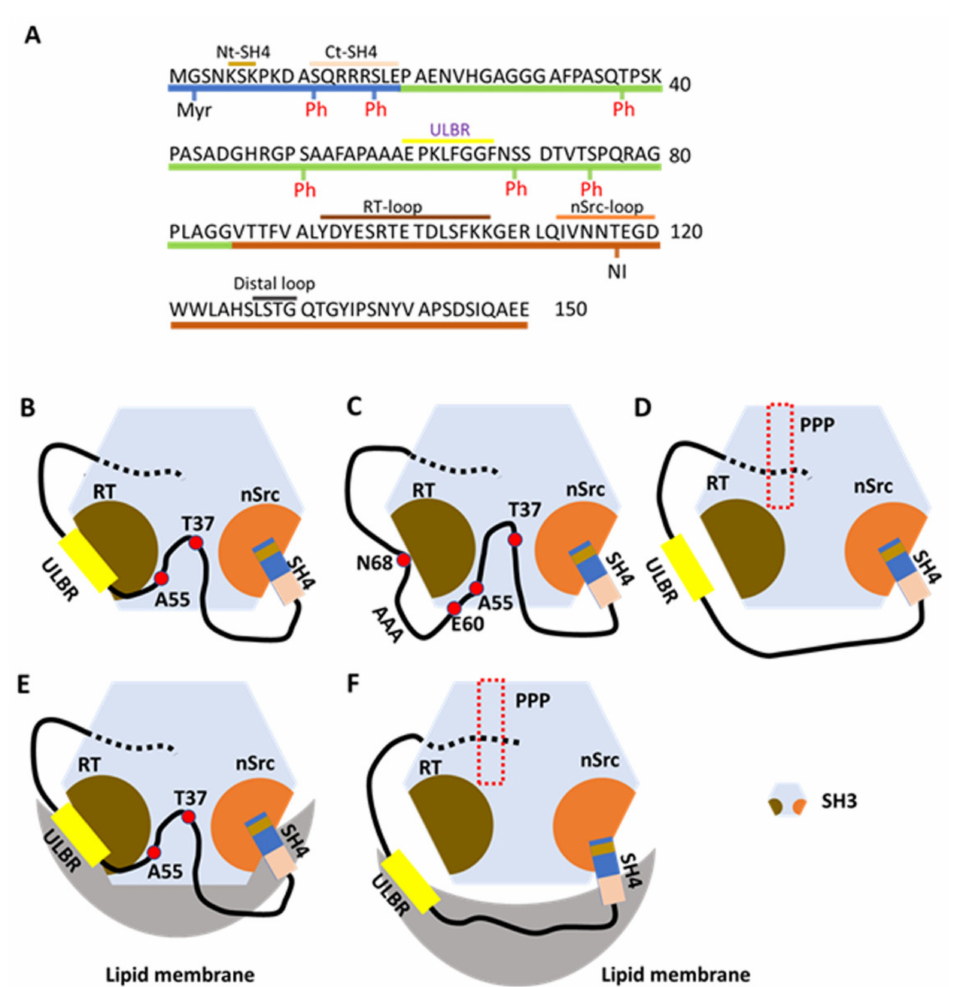
Figure 2. The fuzzy intramolecular complex (FIMC) of N-terminally intrinsically disordered non- myristoylated USrcSH3 scaffolded by SH3. ( A ) The sequence of residues in IDR (SH4 and UD) and SH3. Residues 1–19 are contained in SH4; residues 20–85 are contained in UD; and residues 86–150 are contained in SH3, which are colored as in Figure 1A. Nt-SH4 and Ct-SH4 contain residues 5–7 and 12–19. ULBR, a partially structured region in UD, contains residues 60–67. Three loops, RT, nSrc, and distal loops between each β -sheet (not designated) in SH3, are labeled above the residues. Myristoylation (Myr) and phosphorylation (Ph) sites are shown beneath the residues. Neuronal insertion (NI) occurring in N-Src is also shown under the residues. ( B ) UD interacts with the RT loop of SH3 through residues Thr37, Ala55, and ULBR (between E60 and N68). SH4 interacts with the nSrc loop of SH3 through its N-terminal residues (Nt-SH4). ( C ) Effects of ULBR mutation. The 3A mutant of UD, in which residues LFG in ULBR are replaced by three alanines, displays a small decrease in interaction with SH3, but retains the overall interaction. The 3A mutation disrupts the partially structured state. ( D ) In the presence of PPP (derived from the poly-proline peptide in the linker between SH2 and KD). PPP binding allosterically inhibits the interaction between UD and SH3, but not the interaction between SH4 and SH3. ( E ) In the presence of lipid membranes. SH3 binds to lipid membranes through its RT and nSrc loops. The ULBR binds to lipid membranes and SH4 interacts with lipid membranes through its C-terminal residues (Ct-SH4). Interaction between the SH4-UD and SH3 is retained. ( F ) In the presence of lipid membranes and PPP. PPP abolishes the interaction between SH3 and lipid membranes, as well as the interaction between UD and SH3. SH4-related interactions with SH3 and lipid membranes are retained. ULBR binding to lipid membranes is also retained. Figure 2B–F is adapted from Figure 8 in a previous report [34] (p.